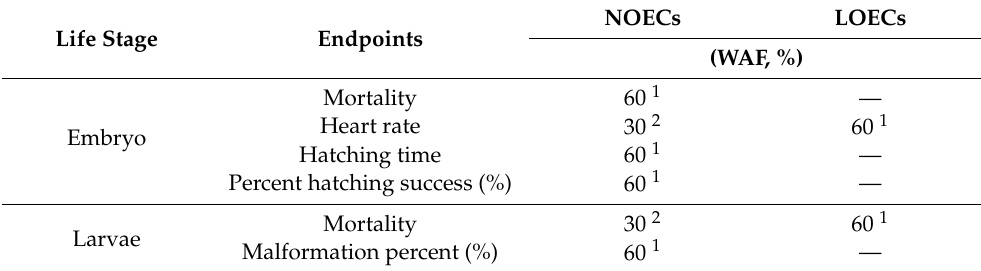
Table 4. NOECs and LOECs of different toxicity endpoints in chronic test.